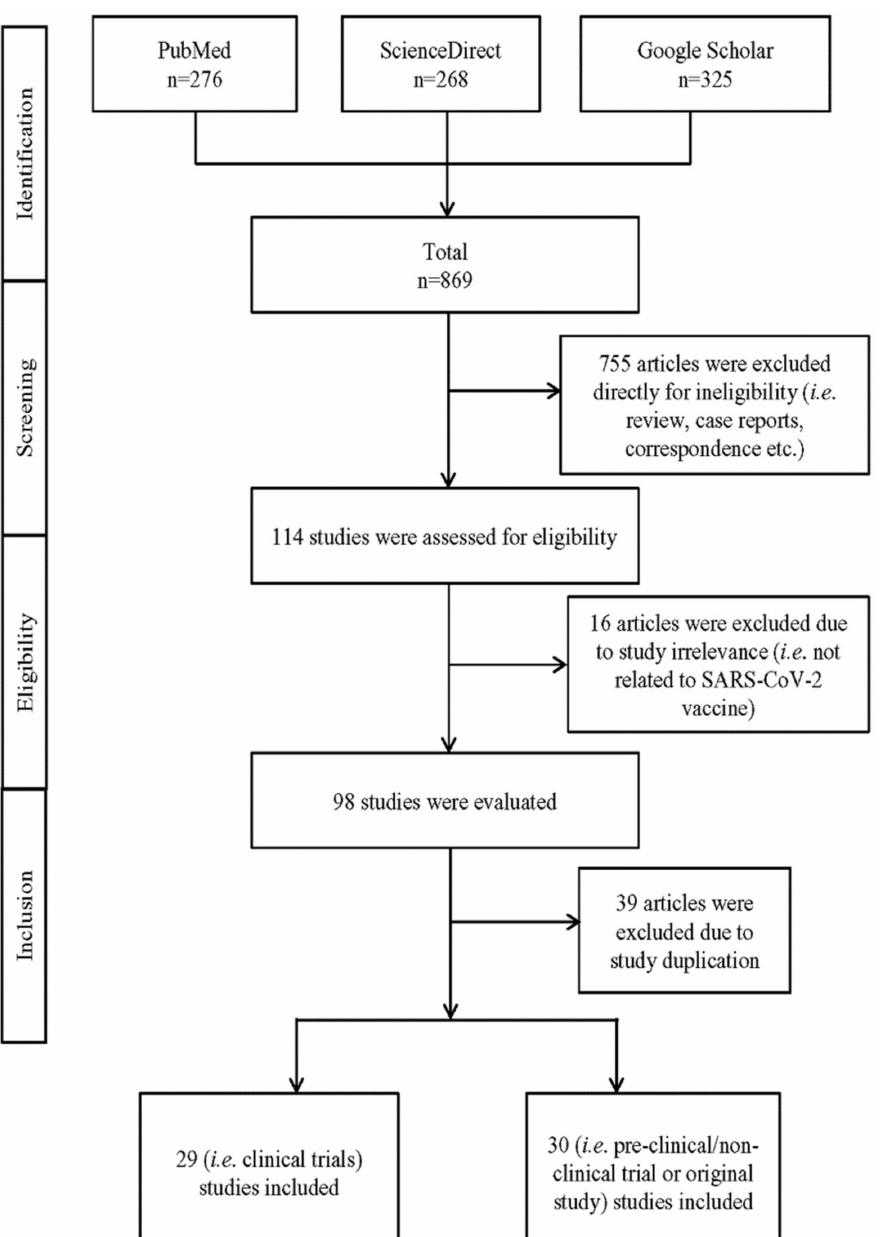
Figure 1. A simplified PRISMA diagram of methodology. Primarily, a total of 869 articles were identified by our search strategy from different online databases (i.e., PubMed, ScienceDirect, and Google Scholar). From this, 755 articles were subsequently excluded due to ineligibility as they were case reports, review articles, correspondence, letters, or articles other than the original full-length article. From the remaining 114 articles, 16 articles were subsequently excluded as they did not match our study criteria (i.e., not related to SARS-CoV-2 vaccines). Ultimately, 59 articles were included for this systematic review after excluding duplicate articles ( n = 39). Among the final 59 studies, 29 were clinical trials, and 30 were pre-clinical, non-clinical, or other original studies on vaccines. Quality assessments were undertaken for clinical